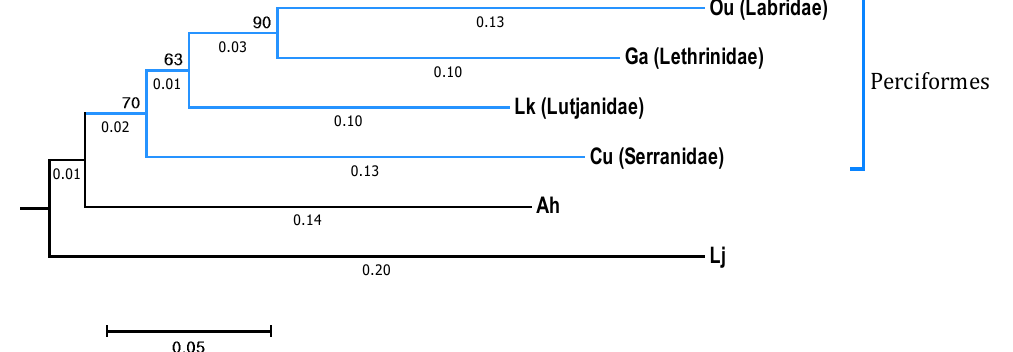
Figure 1. Neighbor-Joining phylogenetic tree of the cytochrome c oxidase subunit I (COI) gene of the four coral reef fishes from the South China Sea with the maximum composite likelihood and bootstrap method (Q = 1000) was rooted by Ah ( Acanthogobius hasta ) and Lj ( Lampetra japonicum ) and constructed with mega 6.0. The clone sequences of the fish were downloaded from NCBI and the locus_tags were KC353468.1, NC_006131.1, MK567523.1, MK658630.1, FJ416614.1, MK566923.1. Ou: O. unifasciatus , Cu: C. urodeta , Lk: L. kasmira , Ga: G. aurolineatus.